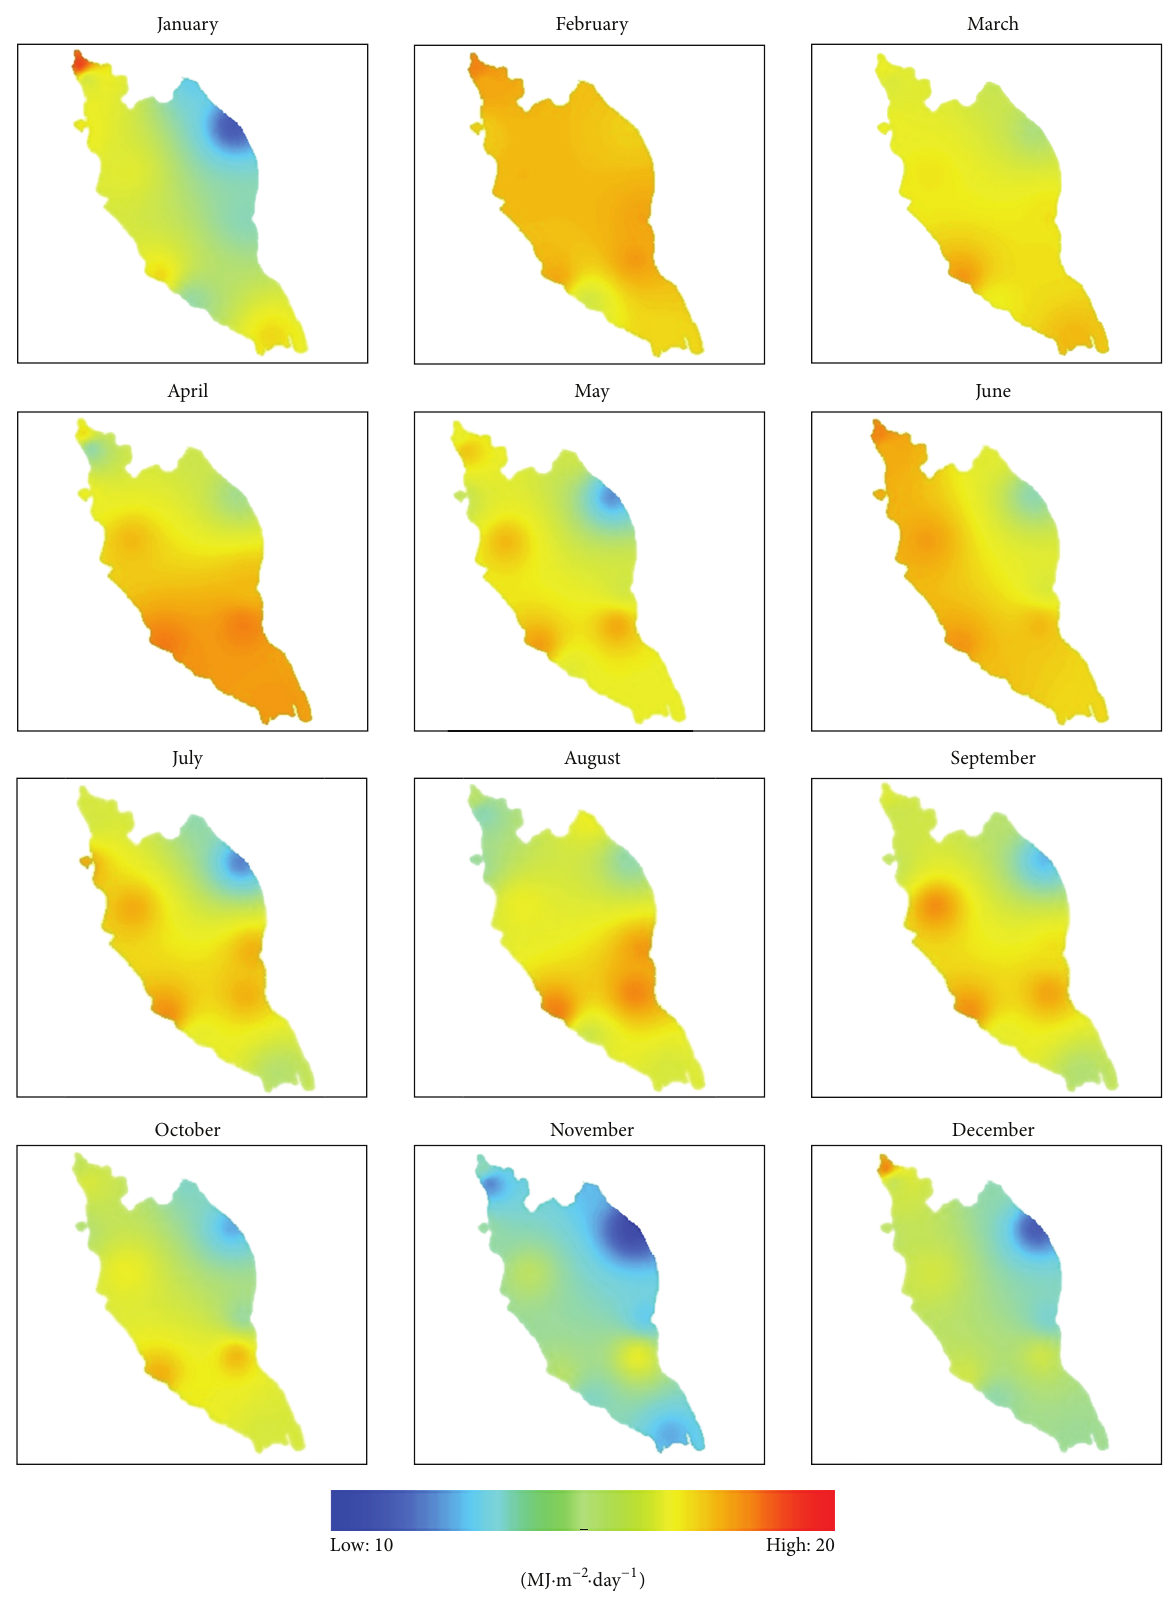
Figure 1: The map of monthly average daily solar irradiation for January until December 2009 Peninsular